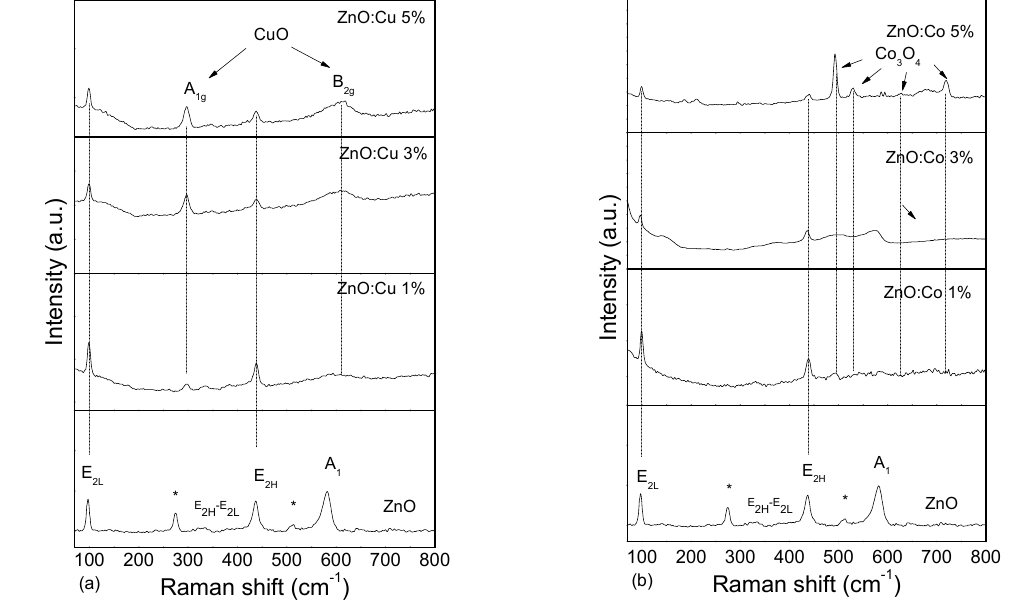
Figure 2. Raman spectra for: ( a ) ZnO:Cu and ( b ) ZnO:Co thin films. Inside the figures are the Raman vibration modes, where (*) corresponds to defects inside the ZnO structure.